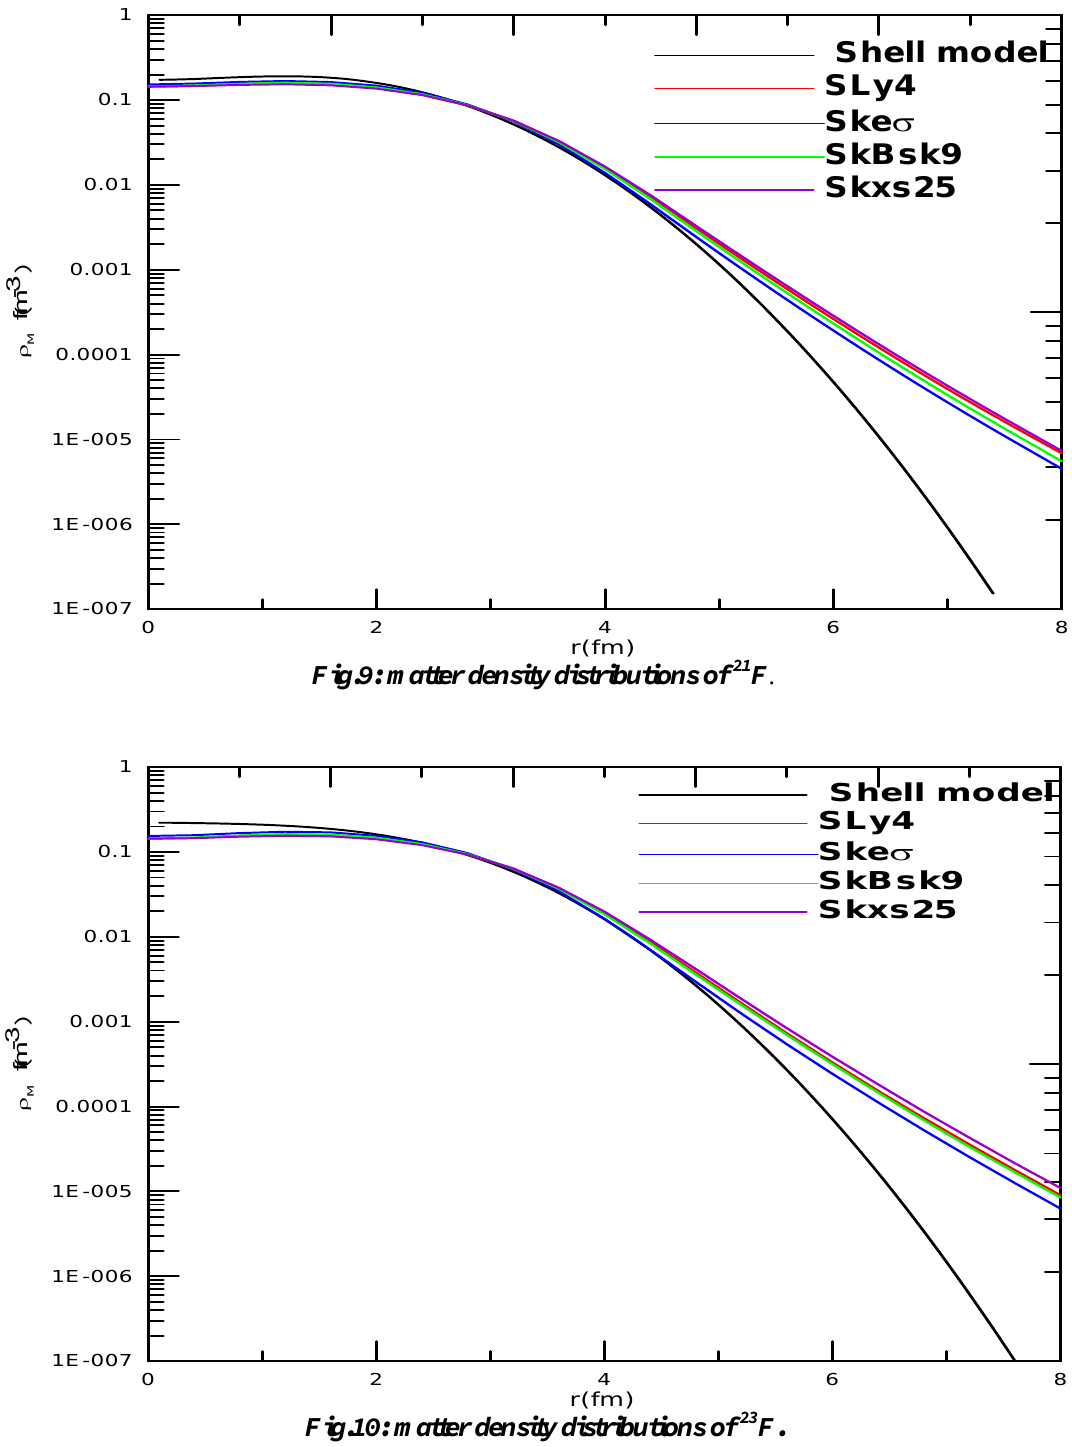
Fig.10: matter density distributions of 23